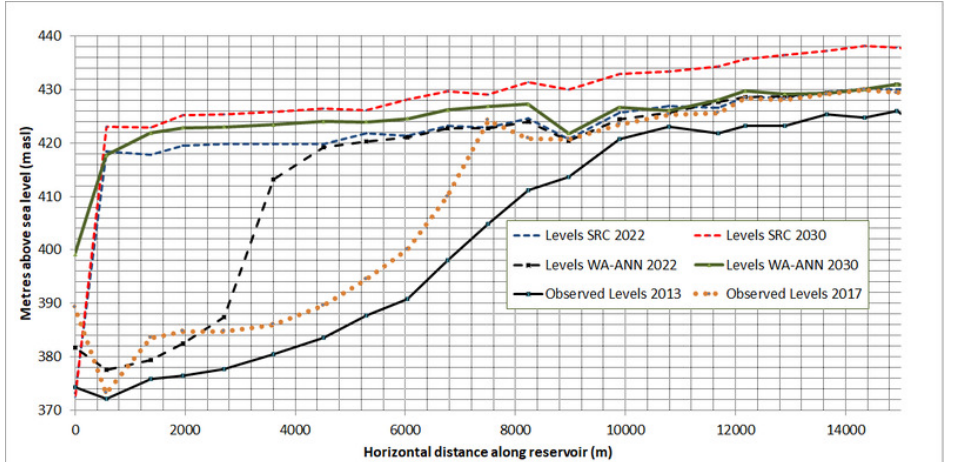
Figure 11. Comparison of simulated bed levels for 2022 and 2030 with the SRC and WA-ANN techniques, along with observed levels of 2013 and 2017. The longitudinal profile is only showing the sediment delta region of Tarbela